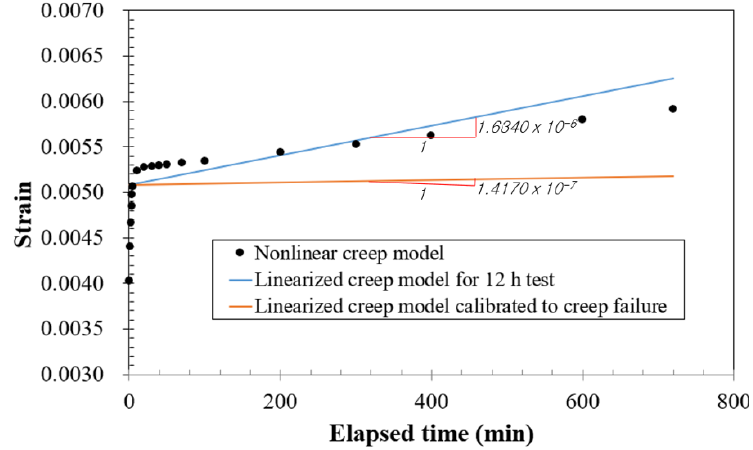
Figure 7. Example of the average creep rate from a nonlinear creep model: Container B, rh = 70%, L o = 0.1652 kN/m, applied load level (% of CS) = 0.1652/2.07 = 7.98%, correction factor = 7.98/(100 − 7.98) = 0.0867 (Tables 4 and 6).